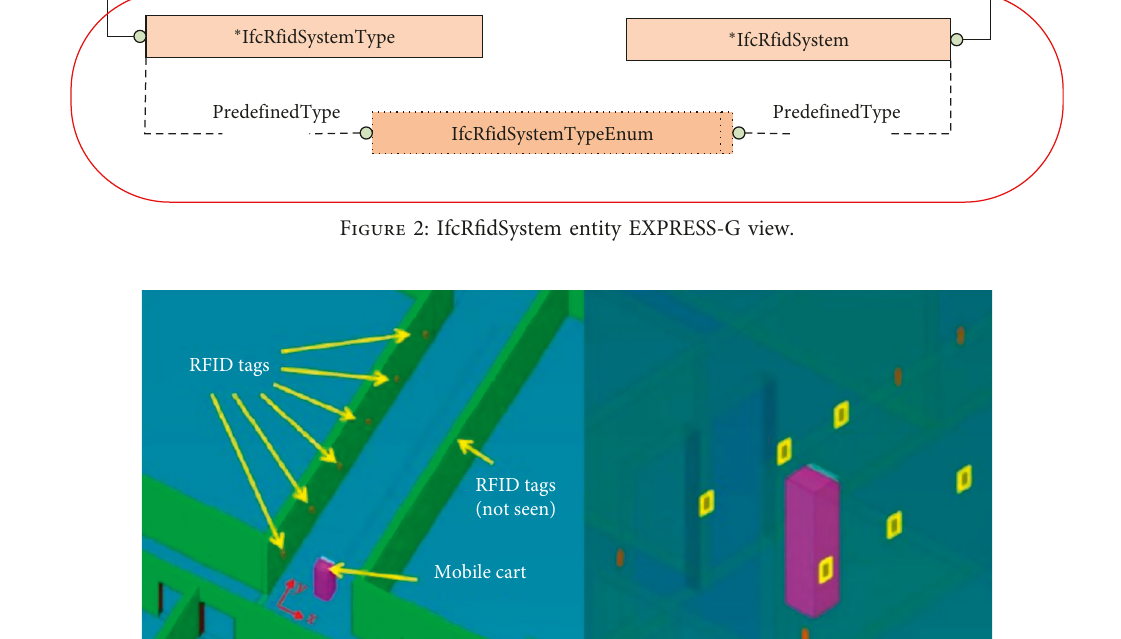
Figure 3: RFID tag